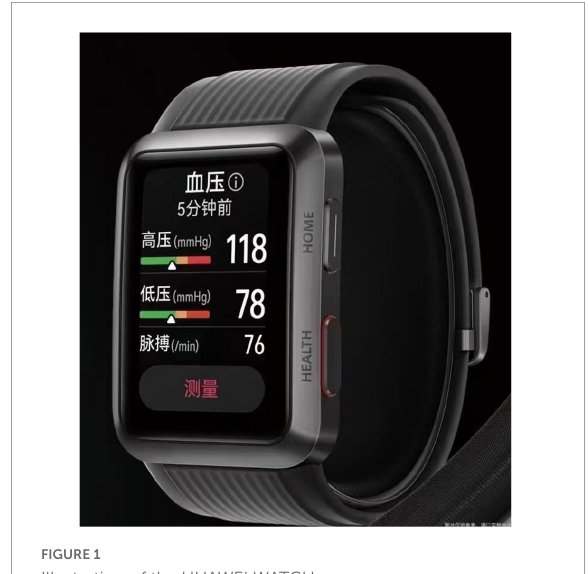
Participants’ BP was measured with their left wrist positioned at the level of the heart, and the time between each set of BP measurements was at least 60